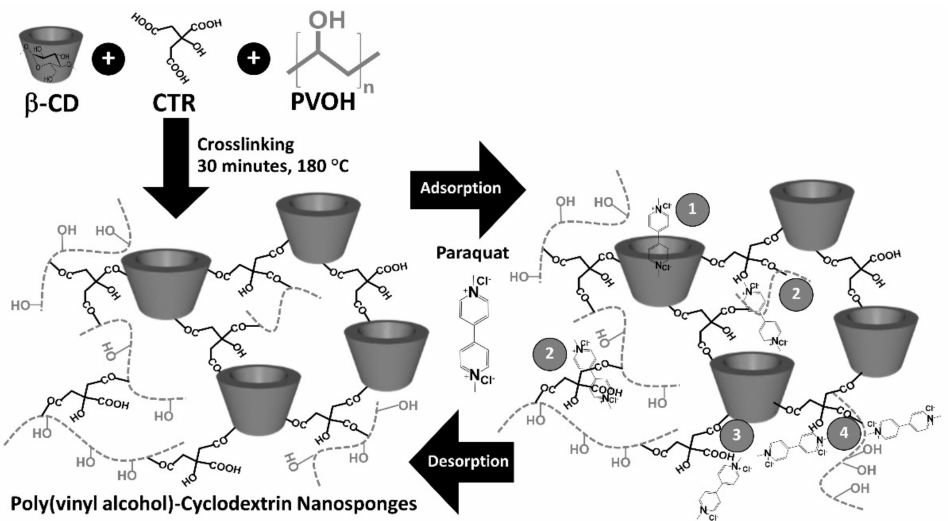
Figure 1. Schematic reaction of poly(vinyl alcohol)-cyclodextrin nanosponges and the possible adsorption mechanism with